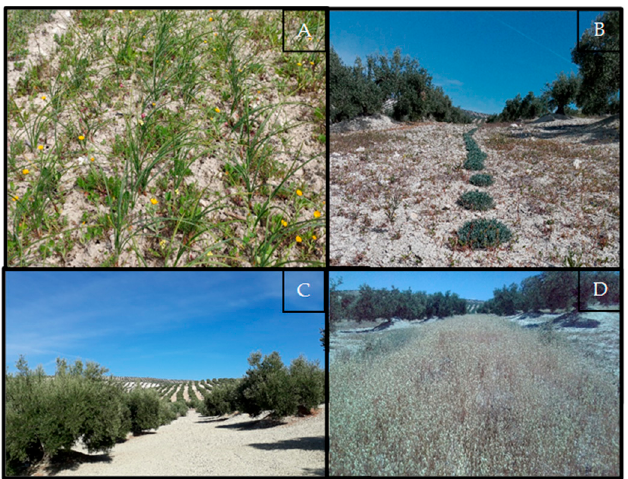
Figure 2. Management systems and crop diversifications implemented in the study area ( A ) Olive intercropping with Crocus sativus , ( B ) Olive intercropping with Lavandula x Intermedia , ( C ) Conventional Tillage, and ( D ) Olive intercropping with Vicia Sativa and Avena sativa in rotation.